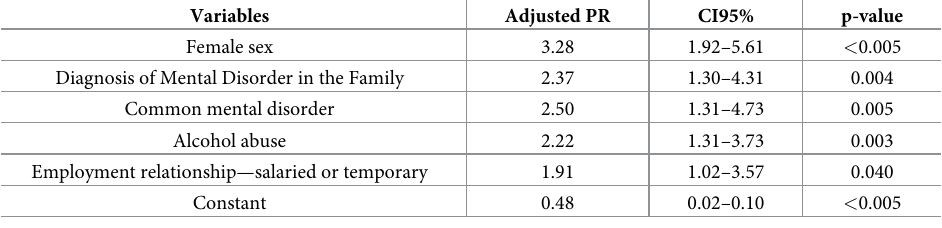
Table 4. Multivariate model between suicidal ideation and its association with sociodemographic, labor and health variables of farmers in the city of